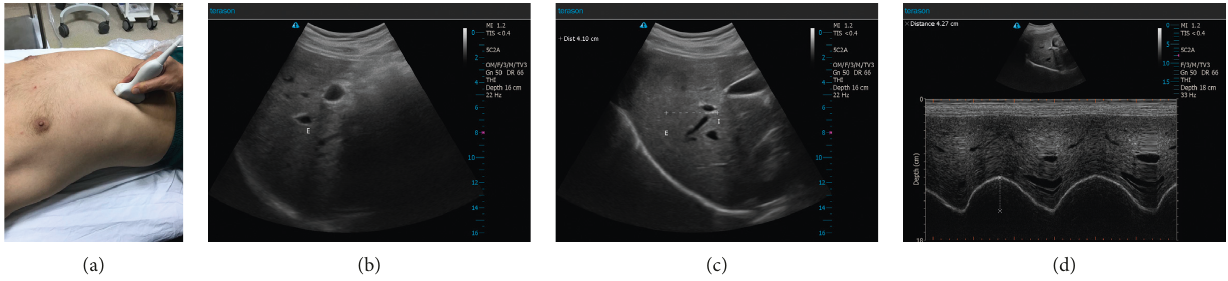
Figure 2: (a) The convex probe is positioned on the abdomen to examine the right diaphragmatic dome. The upward and downward movements of the right diaphragmatic dome were measured from the anterior position. The probe orientation should be longitudinal scan (right hemidiaphragm US method in B-mode and M-mode). (b and c) B-mode ultrasound evaluation of the craniocaudal displacement of the left branch of the portal vein in a patient with COPD. The position of the vessel was marked by the calliper during forced expiration and inspiration manoeuvres. The line shows displacement of the left branch of the portal vein during maximal inspiratory and expiratory breathing in the sagittal plane. The craniocaudal displacement of this branch was registered in millimetres. E marks at maximal end expiration, and I marks the lowest point at maximal inspiration. The distance between E and I is 41mm (Ant B-Mode R). (d). M-mode scan of the right hemidiaphragmatic dome at maximal inspiration The first calliper was placed at the foot of the inspiration slope on the diaphragm echoic line and the second one at the apex of this slope for the deep breathing measurements (Ant M-Mode R: 42.7mm). Table 1: Demographic characteristics and significance levels in control group and COPD patients according to their stages. Control